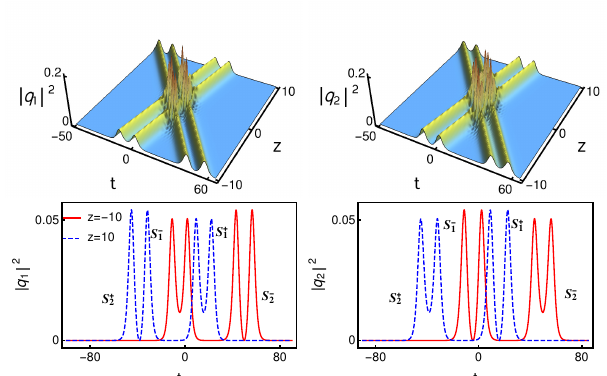
Figure 2. Shape preserving collision of two symmetric double-hump solitons—the energy is not exchanged among the nondegenerate solitons during the collision process. The parameter values are k 1 = 0.333 + 0.5 i , l 1 = 0.315 + 0.5 i , k 2 = 0.315 − 2.2 i , l 2 = 0.333 − 2.2 i , α ( 1 ) = 0.49 + 0.45 i , α ( 2 ) = 0.49 + 0.45 i and α ( 2 ) = 0.45 + 0.45 i . α 2 2 1